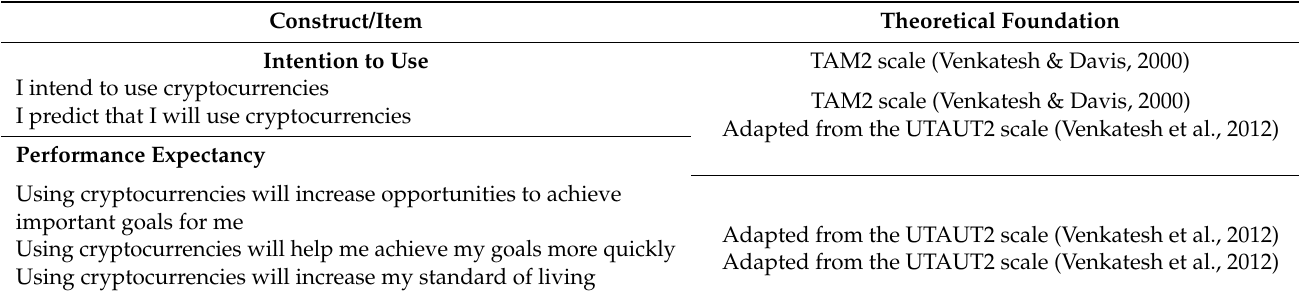
Table 2. Constructs, items and their theoretical